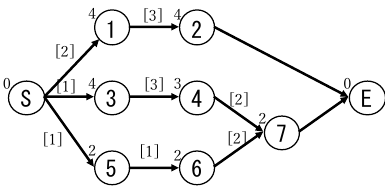
Figure 1. Example of a task